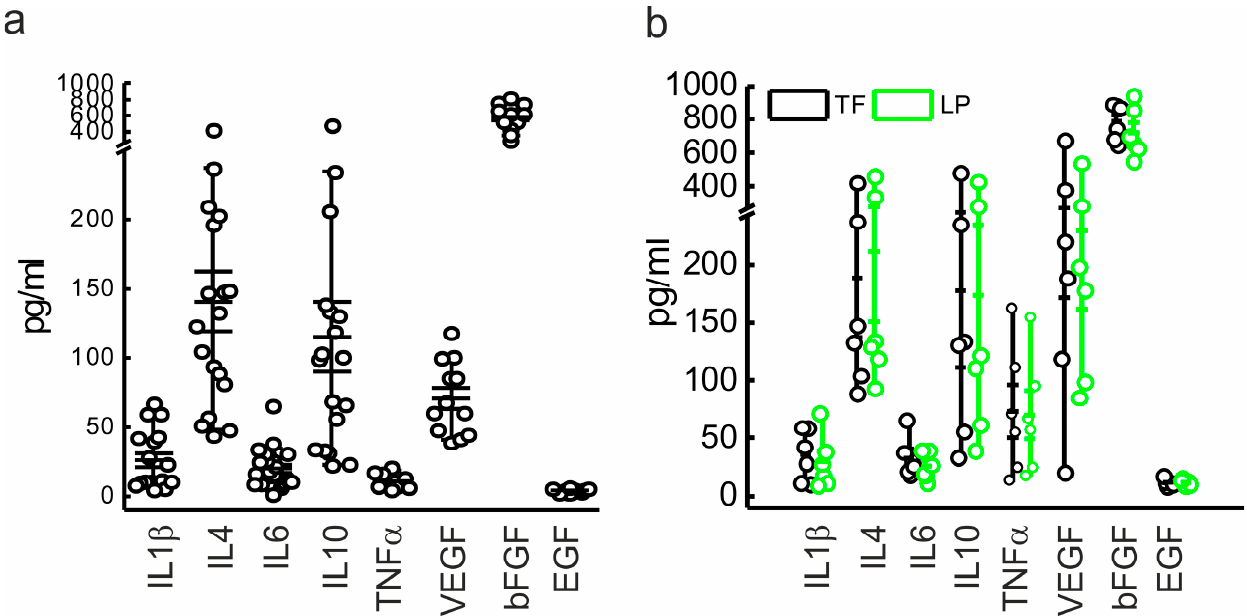
Figure 6. IStemRewind isolates contain more growth factors and immunomodulatory cytokines than pro-inflammatory cytokines. ( a ) Box plots of the concentration determined by specific ELISAs of the indicated proteins in TF extracted by using IStemRewind from 17 lipoaspirates. ( b ) Box plots of the concentration of the indicated proteins determined by specific ELISAs of the TF and in the LP purified by centrifugation from six randomly selected IStemRewind isolates.